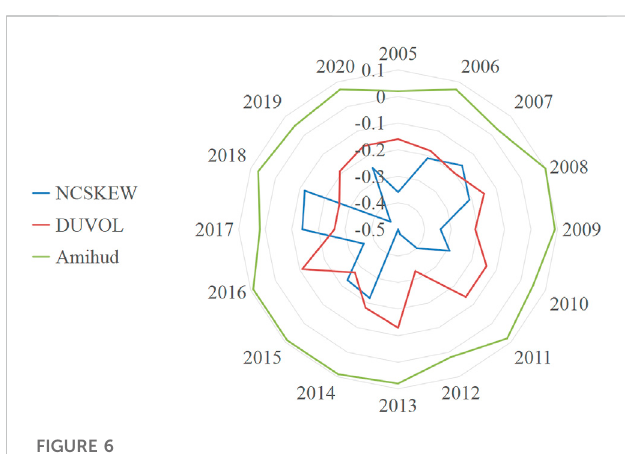
FIGURE 6 Year-by-year statistics of the mean values of key